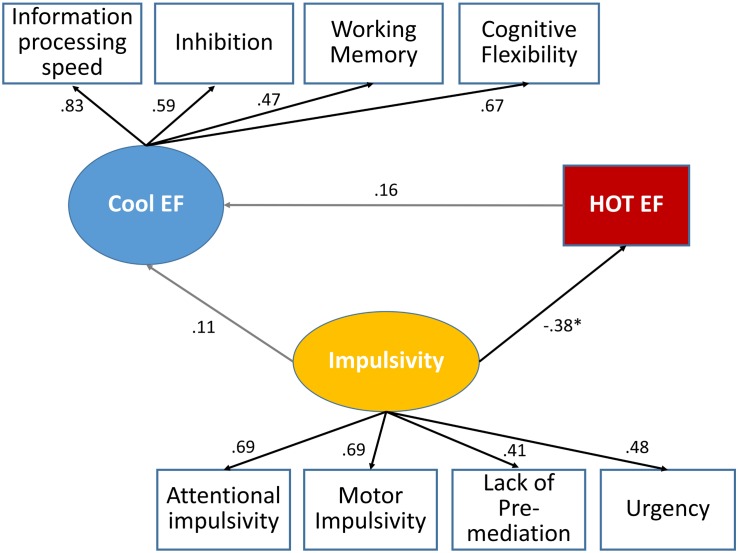
Proposed causal paths of Hot and Cool EF and Impulsivity (standardized solution) for all athletes (n = 86).